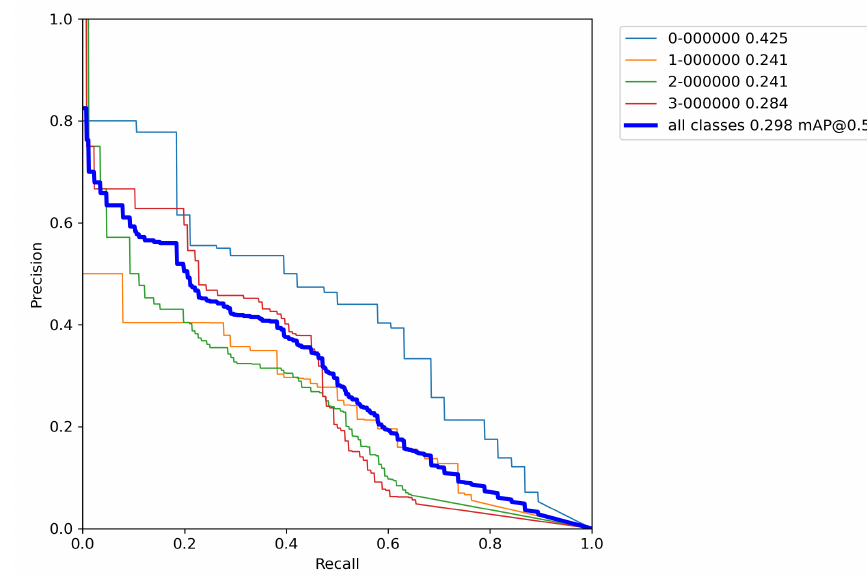
Figure A2. Base model P–R curve—Experiment 2.